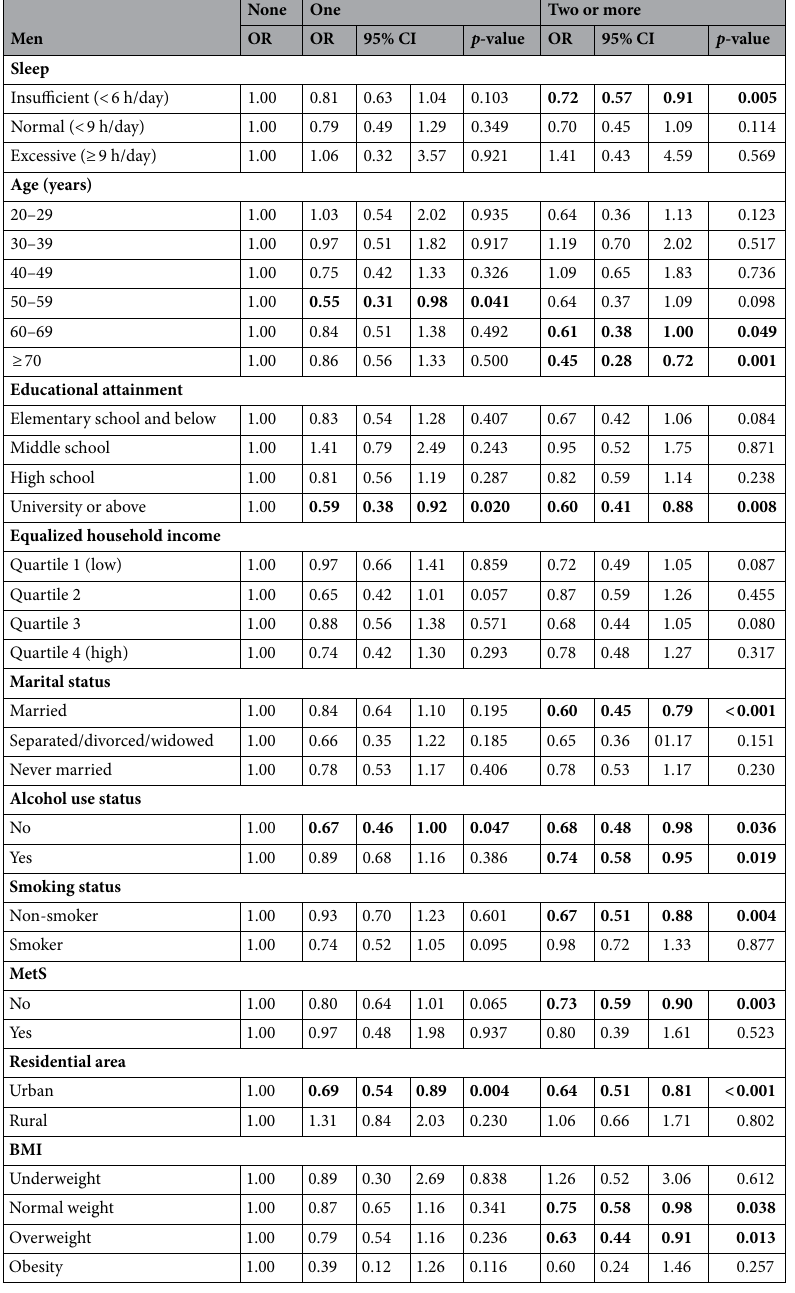
Table 3. Subgroup analysis of the association between exercise variations on depressive symptoms (PHQ-9 ≥ 5) stratified by sociodemographic variables in men. PHQ-9 patient health questionnaire-9, MetS metabolic syndrome, BMI body mass index, OR odds ratio, CI confidence interval. Bold values denote a p-value of